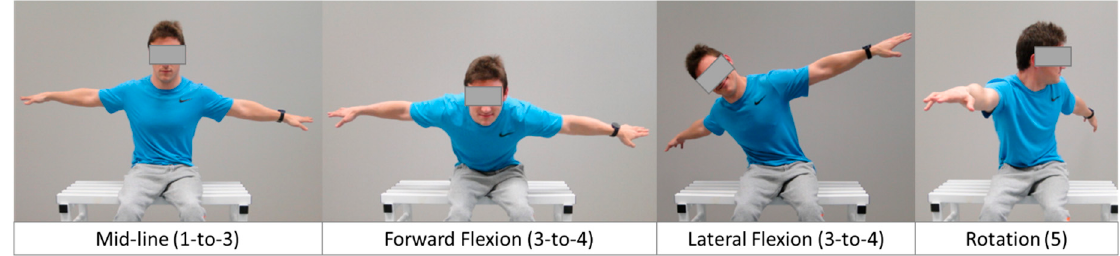
Figure 1. Movements required for scoring trunk function according to the Boccia International Sports Federation (BISFed) trunk function scale (TFS). Table 2. Classifiers’ profiles that conducted Boccia International Sports Federation (BISFed) trunk function scale (TFS) assessments.